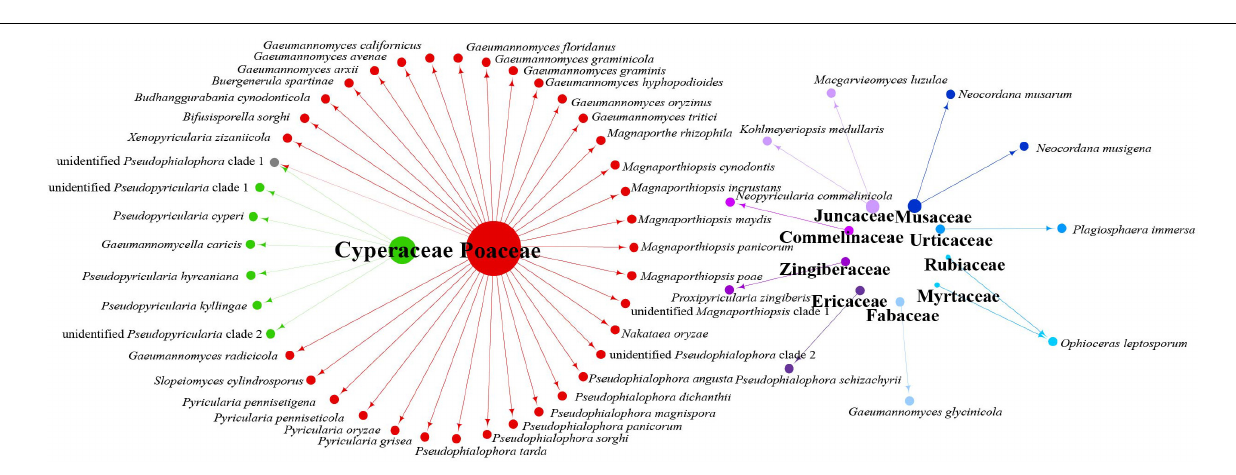
FIGURE 5 | Network of parasitic fungal Magnaporthales species from different host families using